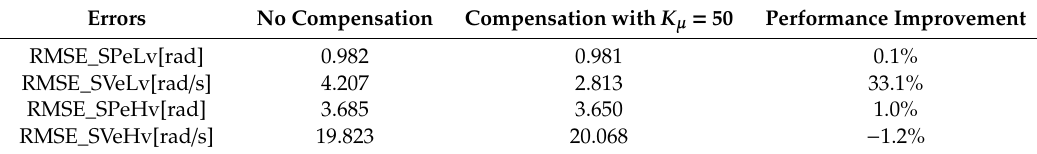
Figure 11. Motor low-velocity without payload experiment results. ( a ) Observed total friction torque mapped to the motor side at low velocities. ( b ) Normalized actual motor velocity (NV) and normalized friction torque (NF). ( c ) Motor position tracking errors at low velocities. ( d ) Motor velocity tracking errors at low velocities. Table 5. Position and velocity tracking error comparison without payload 2